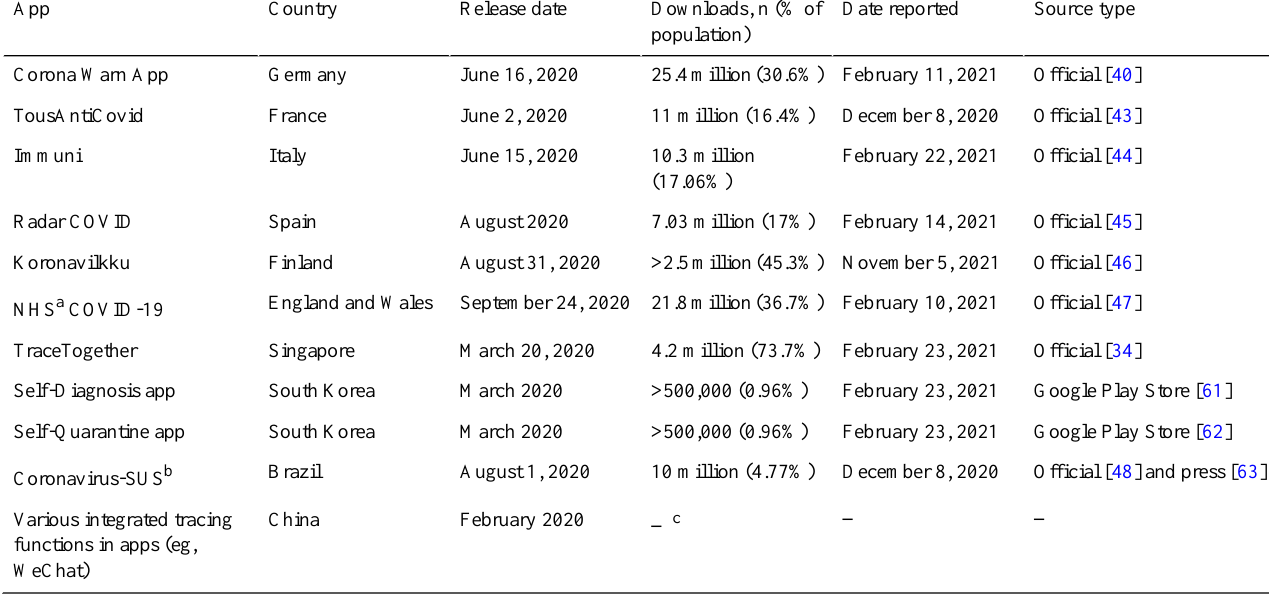
Table 4. Availability and